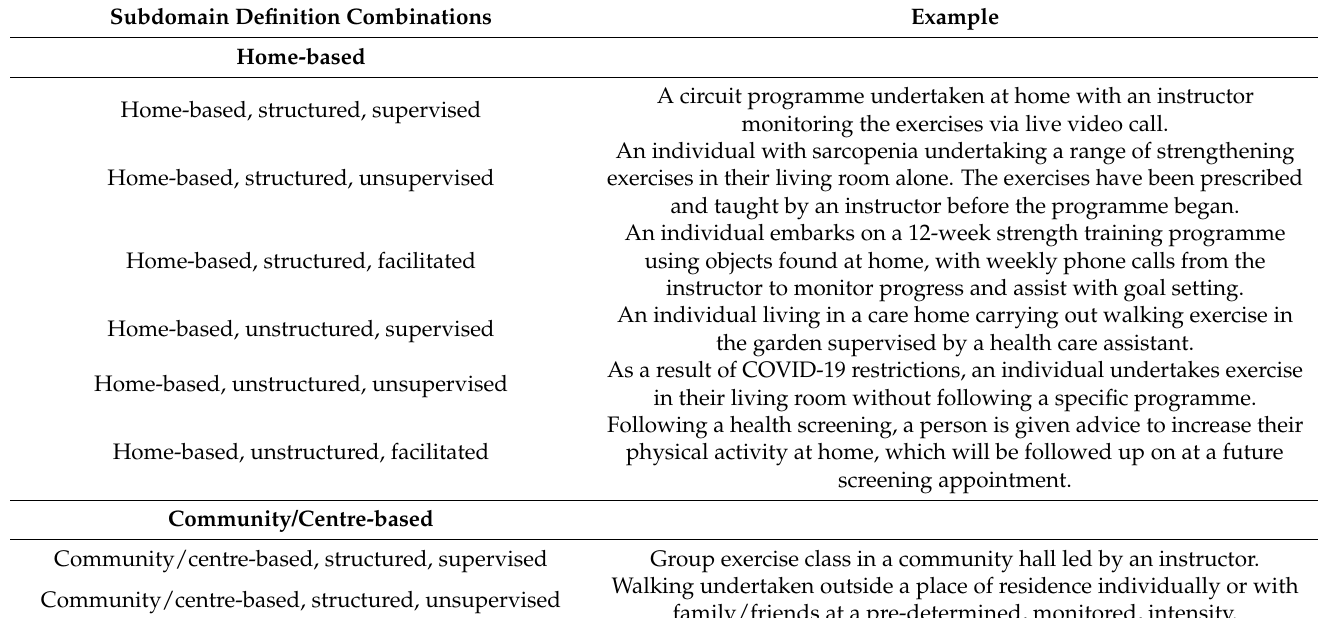
Table 2. Case study